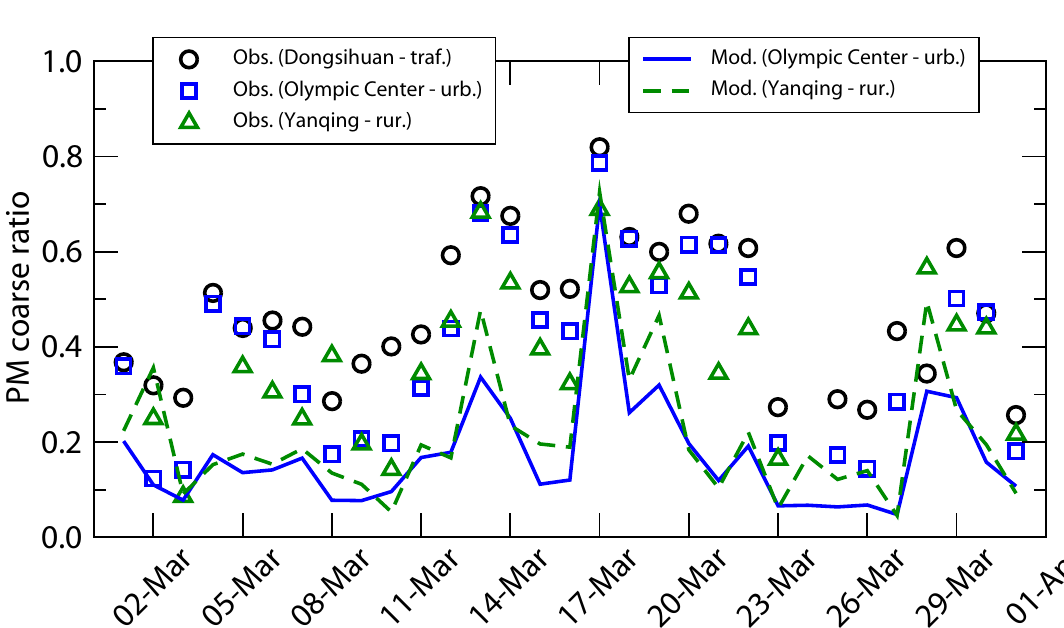
Figure 26. Evolution of the ratio PM coarse /PM 10 in March 2014 for traffic (Dongsihuan 39.95 ◦ N–116.49 ◦ E), urban (Olympic Center 39.98 ◦ N–116.40 ◦ E) and rural (Yanqing 40.45 ◦ N–115.97 ◦ E) stations in the Beijing area from observational data and CHIMERE model outputs (not reported for the traffic station as the simulation resolution is not